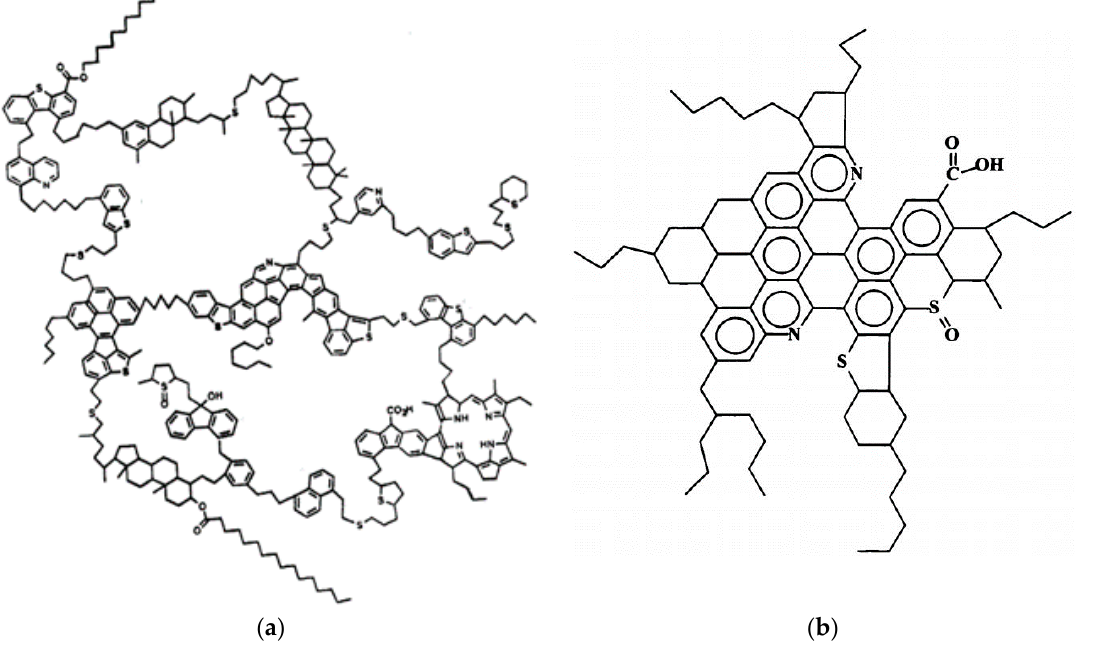
Figure 1. Asphaltene hypothetical structure: ( a ) Archipelago structure, and ( b ) continent structure (reprinted from [25,26] with the permission of the American Chemical Society and OnePetro).